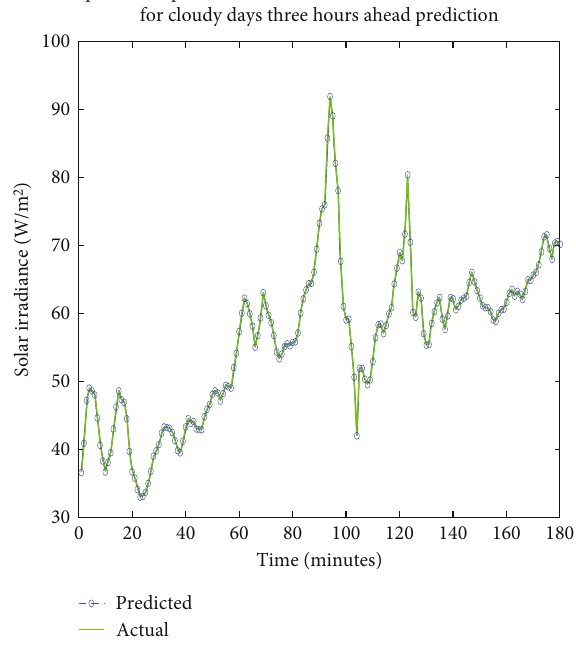
Figure 28: Comparison of predicted solar irradiance and actual solar irradiance for cloudy day three-hour-ahead prediction.